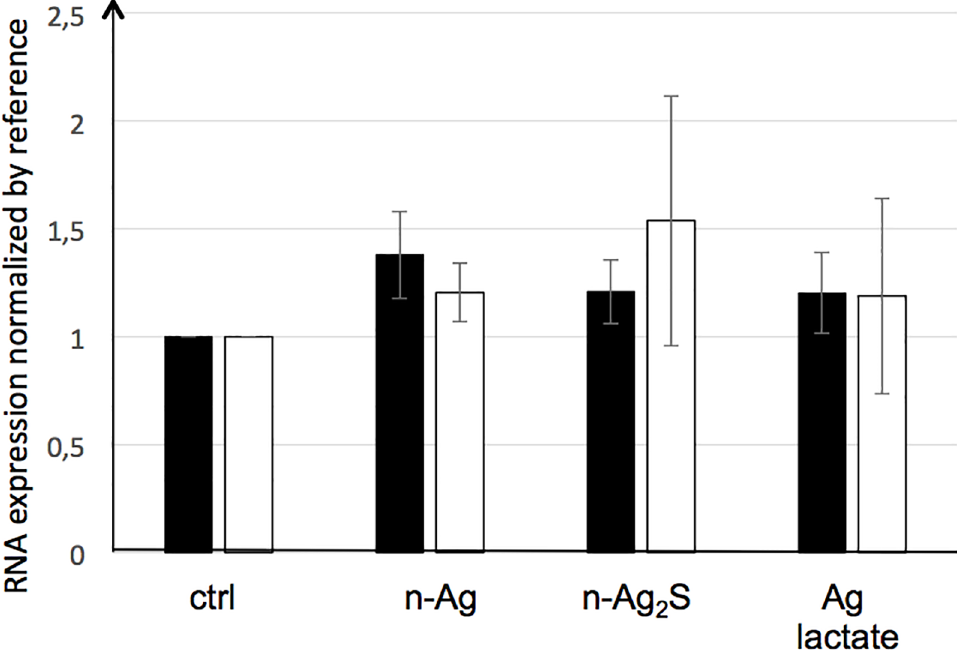
Fig 4. Real-time quantitative polymerase chain reaction (RT-qPCR) of ggt and pgdS mRNA. The expression of ggt (black) and pgdS (white) was measured by qRT-PCR on Bacillus subtilis exposed to 1 mg/L of silver nanoparticles (n-Ag), 1 mg/L of n-Ag 2 S or 1.8 mg/L of Ag lactate. The RNA expression is described in the Materials and Methods section. Error bars ± 1 standard deviation ( n (cid:21) 3).